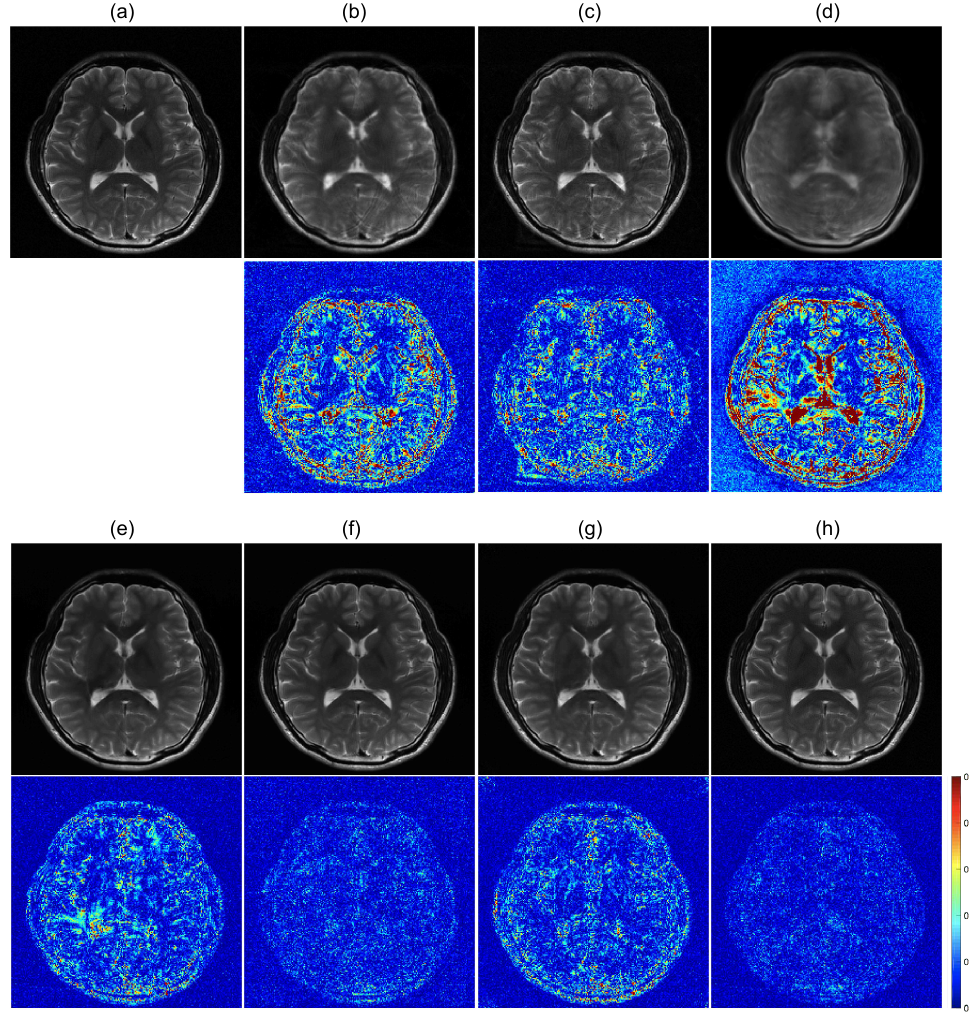
Figure 7. Comparison of previous methods with the proposed method. first and third row : Mag- nitude images. second and fourth row : Corresponding error maps in the 1/10 range. ( a ): Ground truth magnitude images (label images). The images are reconstructed by ( b ): DFU, ( c ): DAGAN, ( d ): k-space deep learning, ( e ): baseline loss, ( f ): baseline loss + perceptual loss, ( g ): baseline loss + adversarial loss, and ( h ): baseline loss + adversarial loss + perceptual